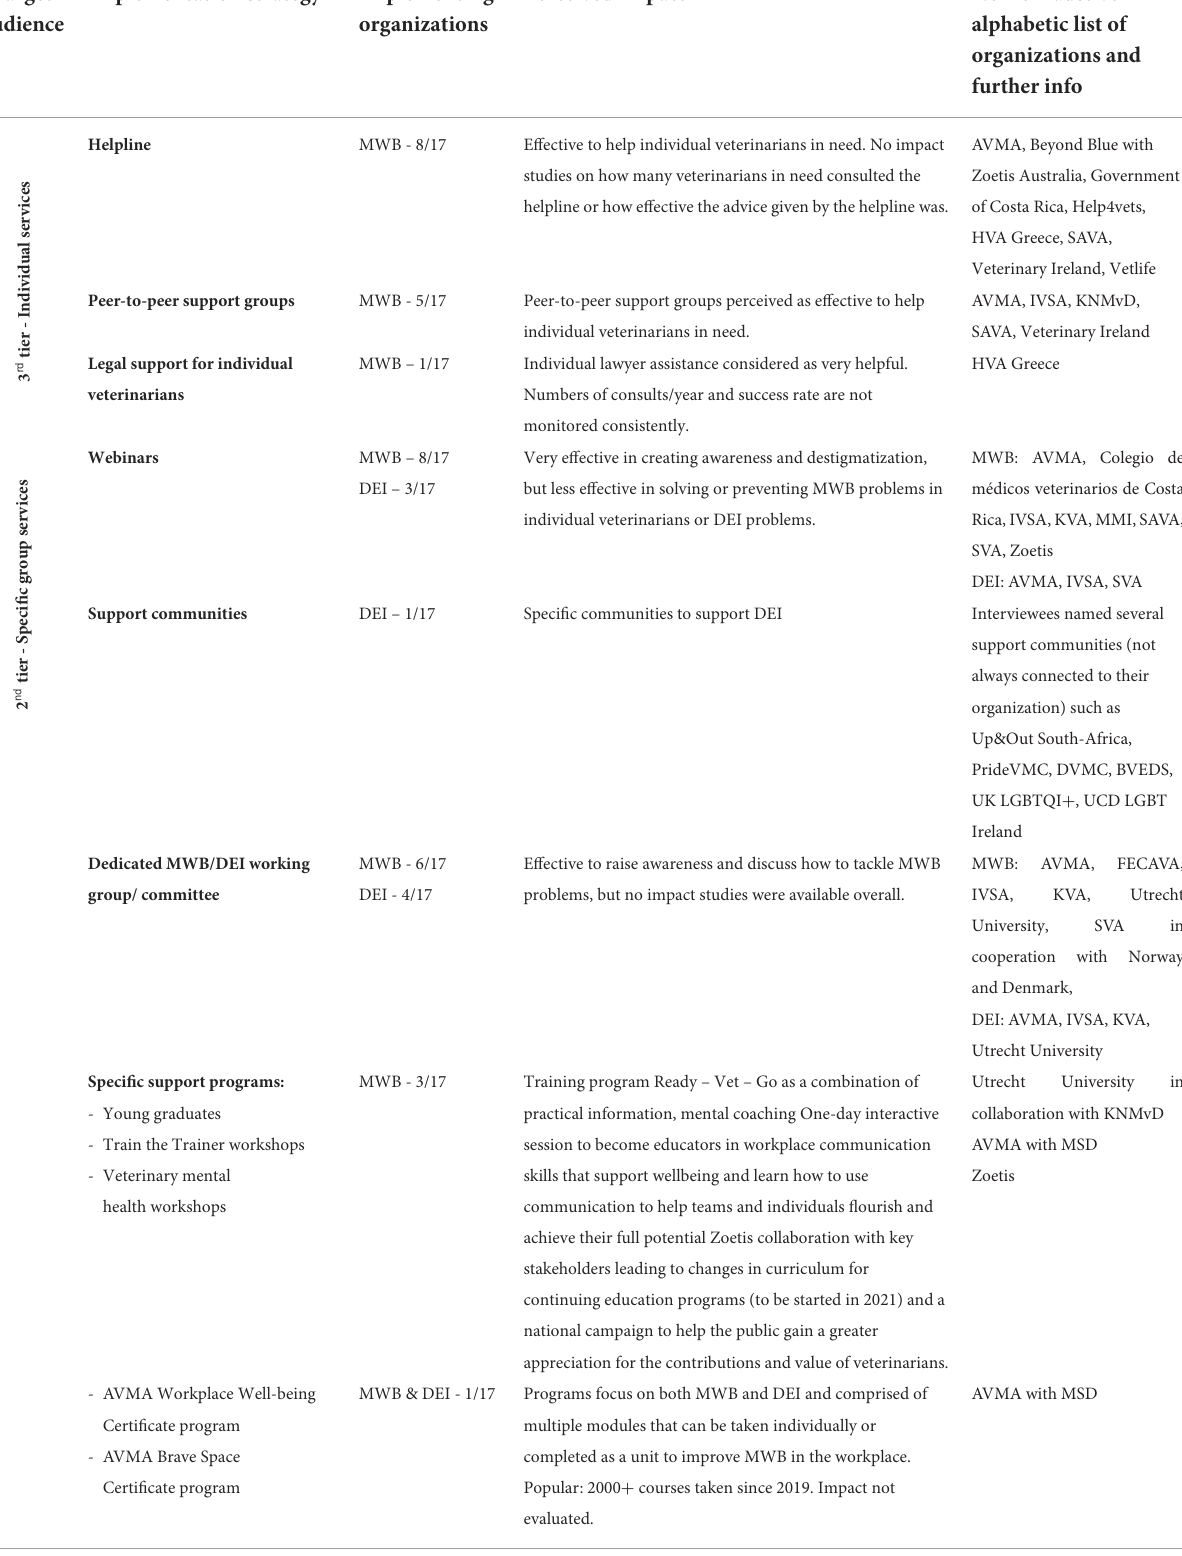
TABLE 2 Perceived impact of support programs by interviewed organizations per tier and implementation strategy.